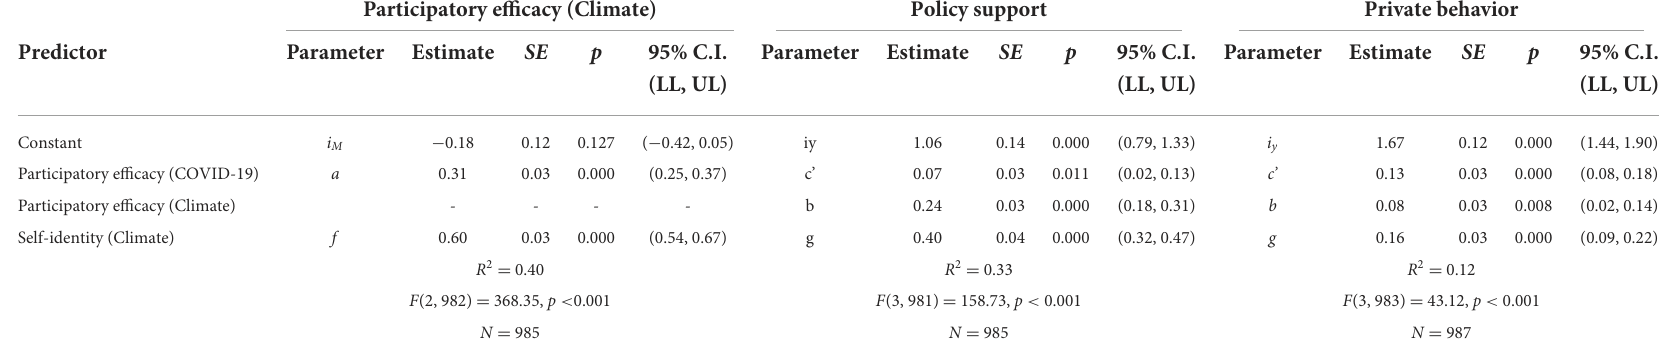
TABLE 2 Model coefficients for the mediation model assuming an indirect effect of COVID-19-related participatory efficacy on behavioral responses via climate-related participatory efficacy, with self-identity as